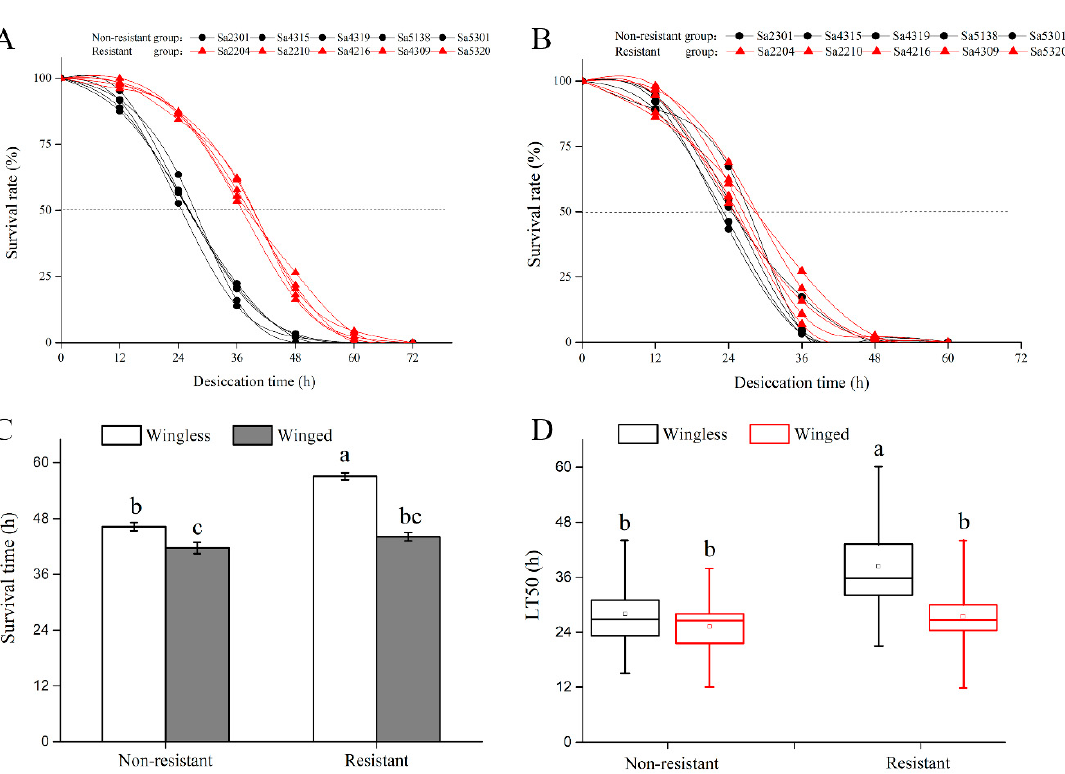
Figure 2. Comparisons of survival between nonresistant and resistant genotypes for winged and wingless Sitobion avenae exposed to desiccation stress: ( A ) survival rates for wingless individuals; ( B ) survival rates for winged individuals; mortality rates at 12-h intervals; ( C ) survival time; ( D ) LT50. Data are shown as box plots: the horizontal bar represents the median value while the empty dot means the mean value, the whiskers shown below and above each box represent the minimum and maximum, respectively) Different letters above bars indicate significant differences between treatments.